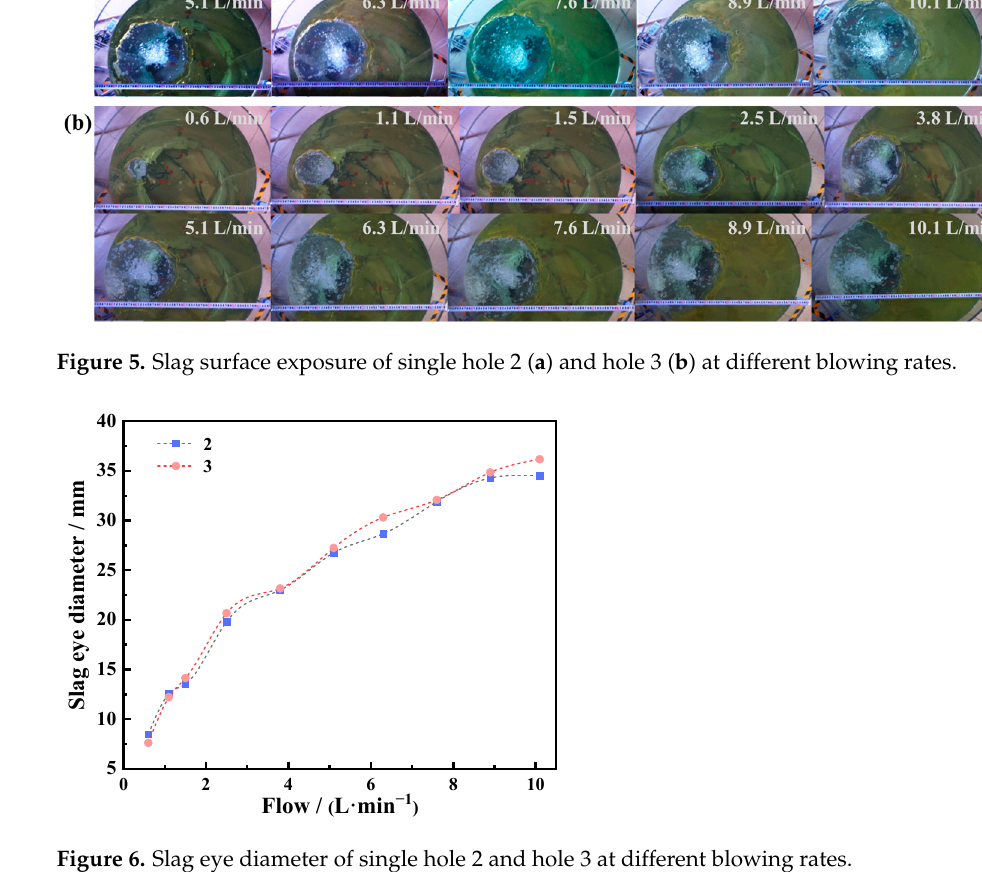
Figure 6. Slag eye diameter of single hole 2 and hole 3 at different blowing rates.